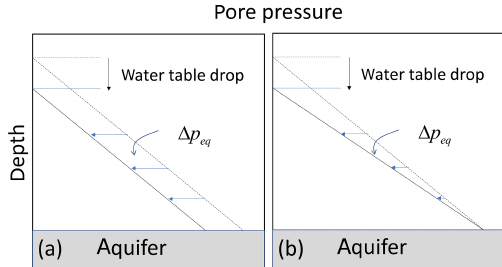
Figure 3. Change of equilibrium (drained) pore pressure due to a drop of the water table. (a) Aquifer pressure (and head) follows the water table drop. (b) Aquifer pressure (and head) remain